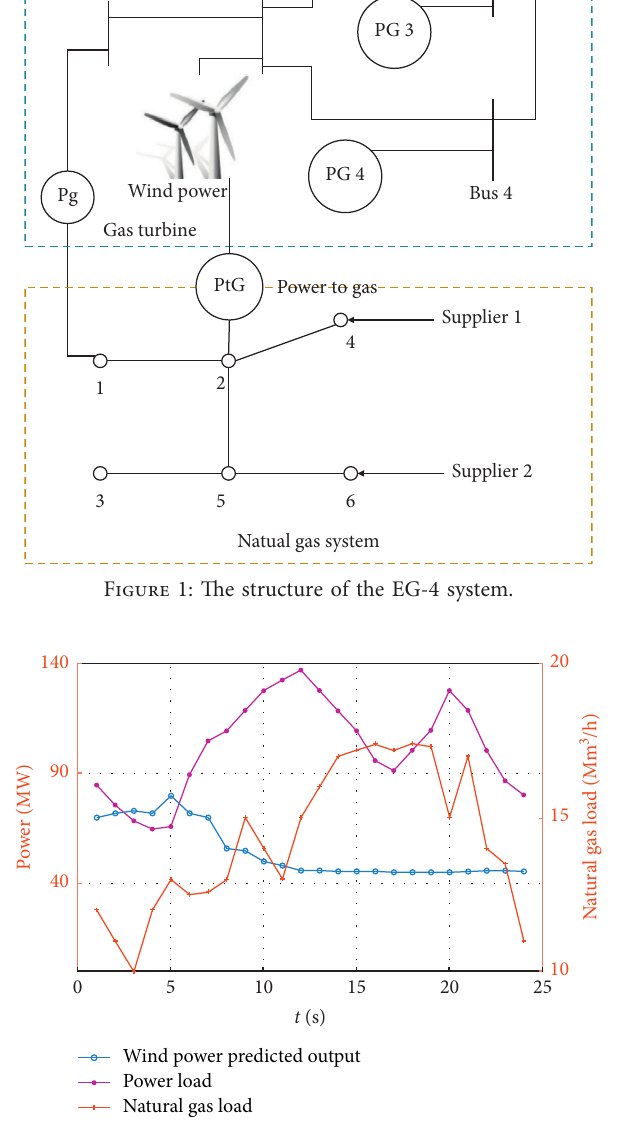
Figure 2: The curves of forecasted wind power output, power load, and natural gas